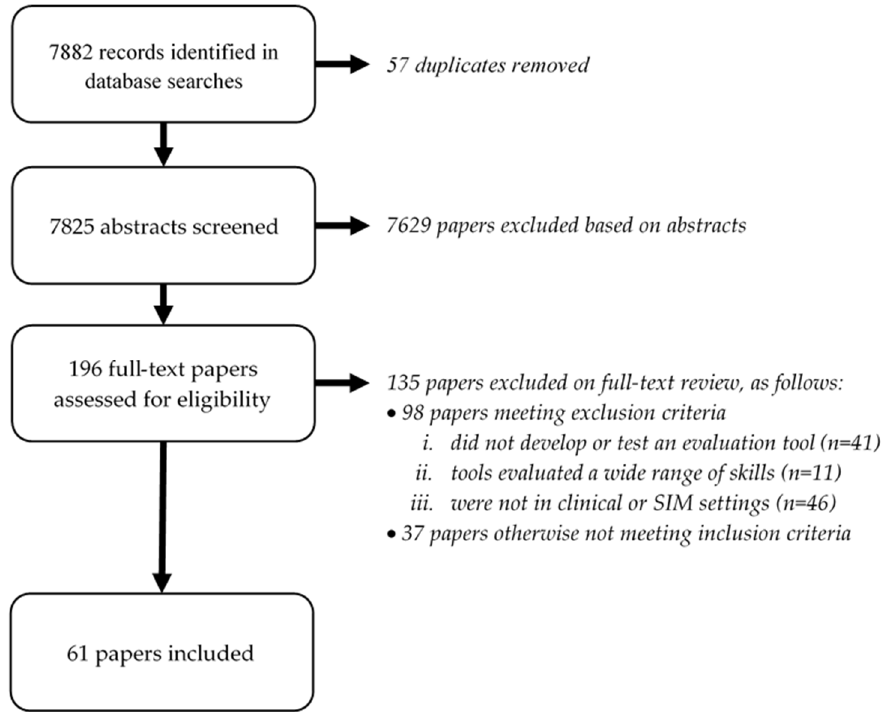
Figure 1. Flow diagram of search.